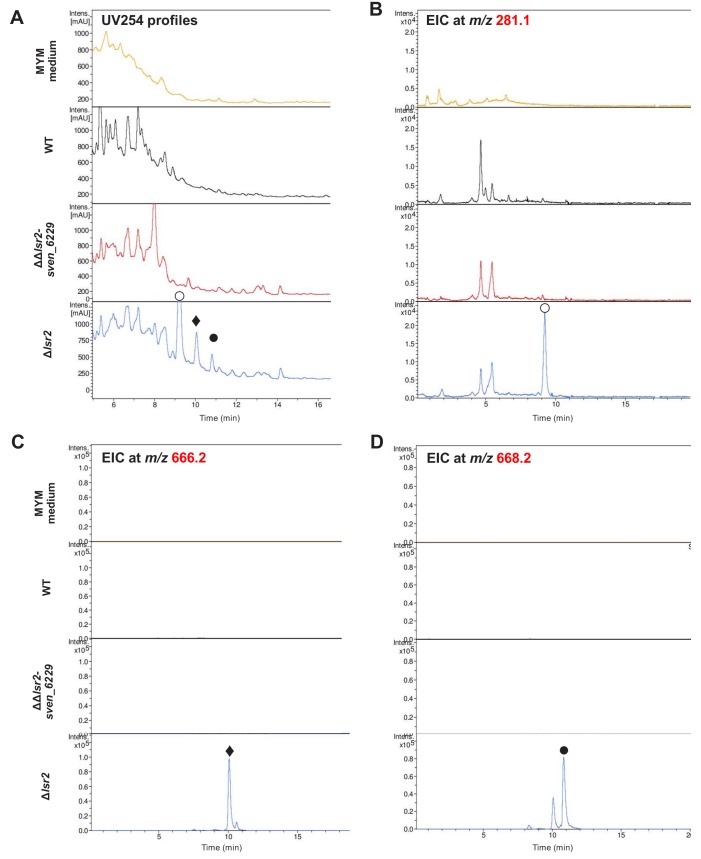
Deletion of a halogenase-encoding gene leads to loss of multiple molecules.(A) UV254 profiles for medium control (MYM), wild type S. venezuelae (WT), the double lsr2 sven_6229 mutant, and the single lsr2 mutant. In the lsr2 mutant, three new peaks are marked with a filled diamond, and open and filled circles. (B) Positive ion mode xtracted ion chromatogram (EIC) for the open circle peak at m/z 281.1. (C) EIC for the filled diamond peak at m/z 666.2. (D) EIC for the filled circle peak at m/z 668.2.